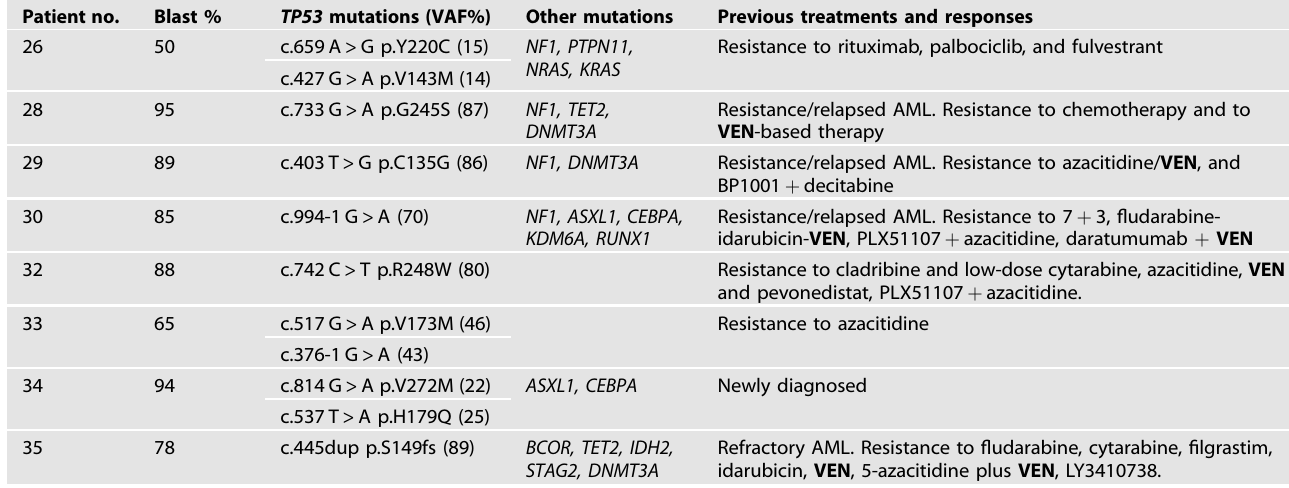
Table 1. Patient characteristics. Patient